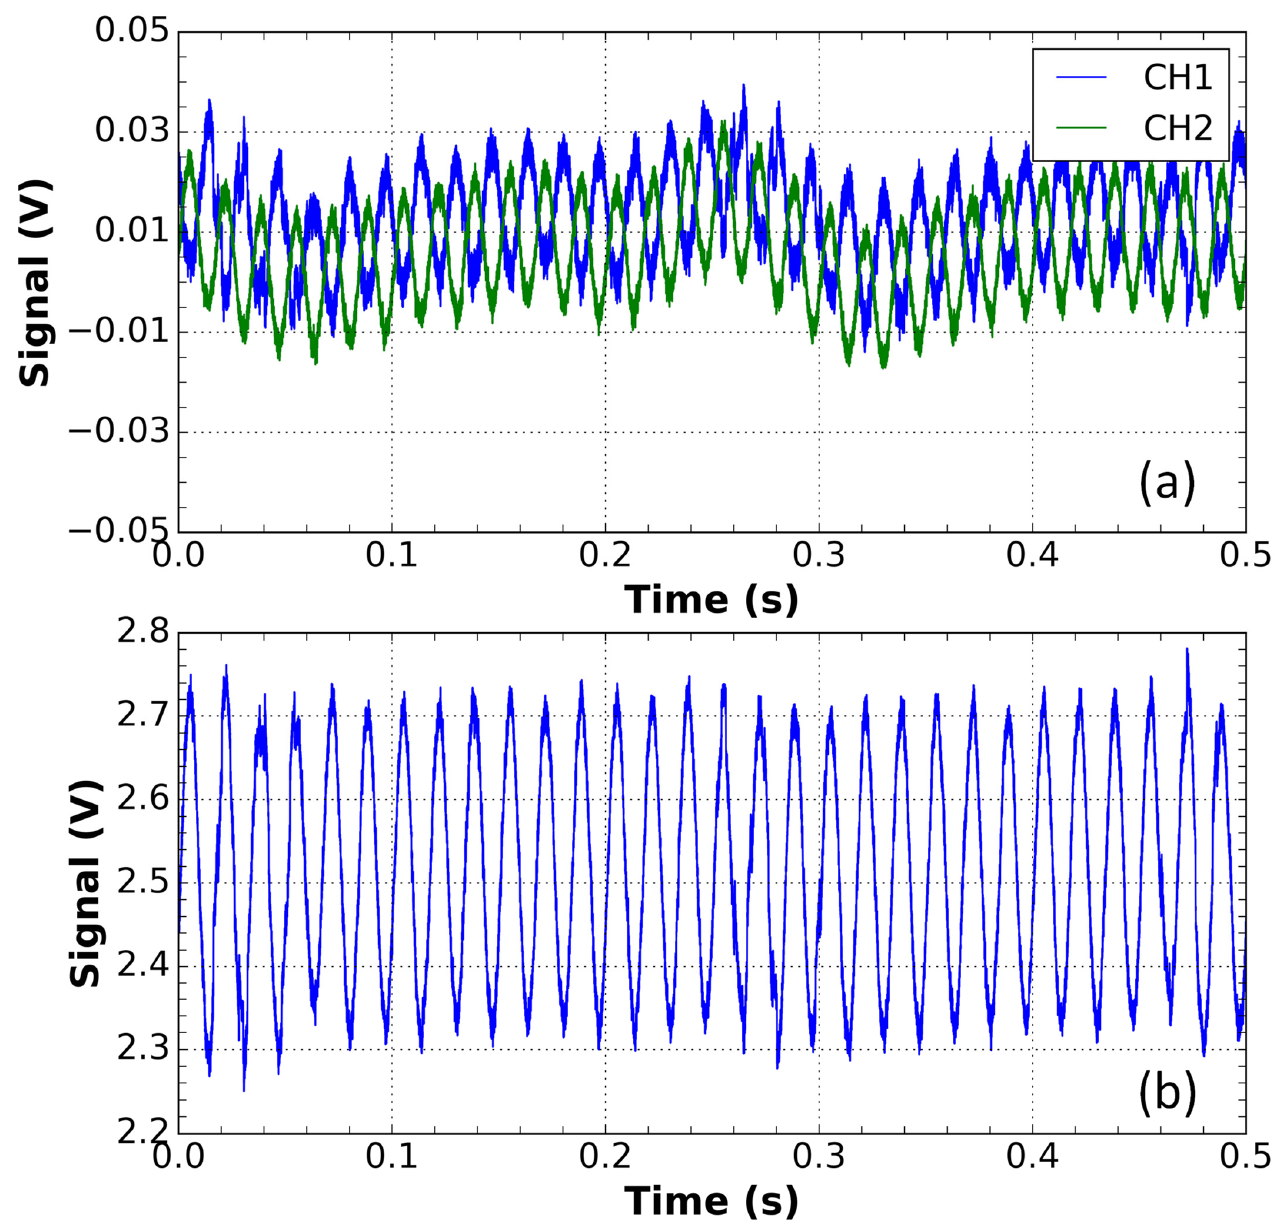
Figure 9. Measurements for the sensor outside the DWDM network. ( a ) Waveforms of the CH1 and CH2 channels of the voltage sensor output in the presence of a disturbance with an applied voltage of 9.56 kV. These signals were subtracted to compensate for the amplitude variation; ( b ) the result of this subtraction.